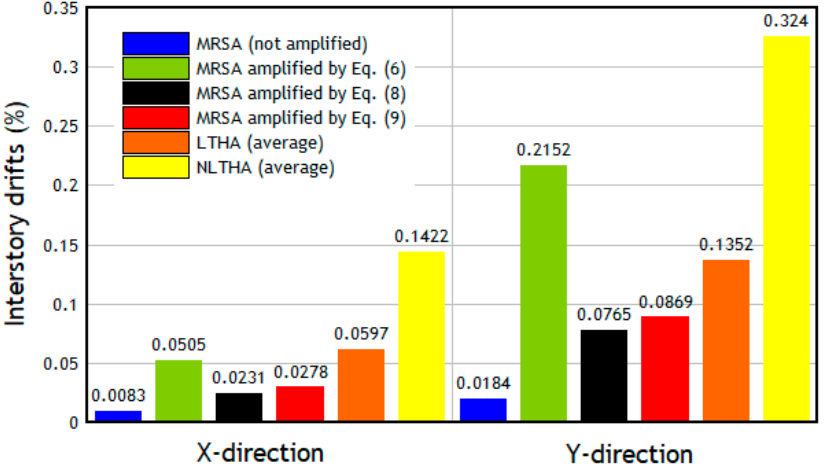
Figure 16. Histogram with the interstory drifts predicted by the different analyses.